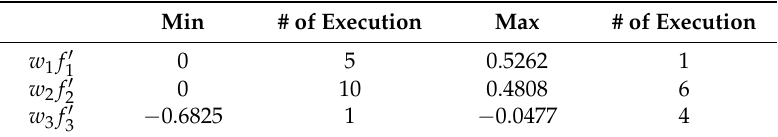
Table 6. Maximum and minimum values are found in the Pareto-optimal